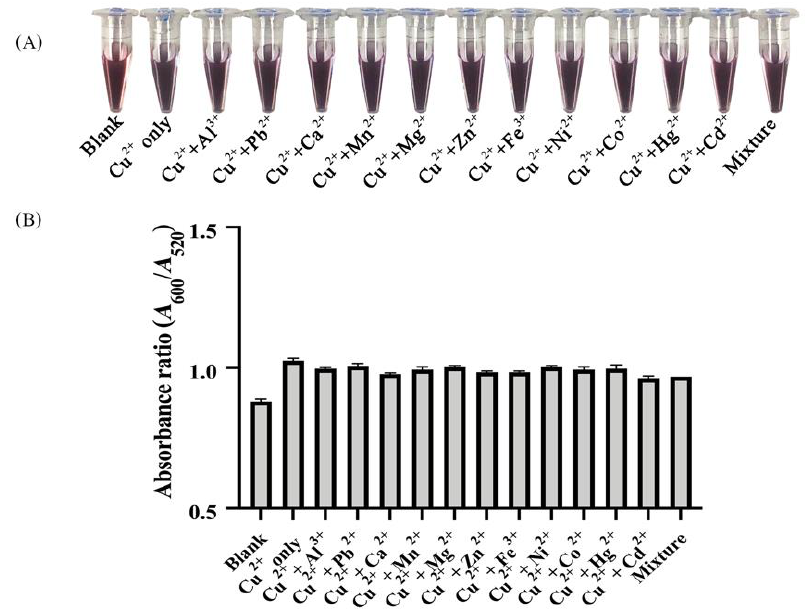
Figure 8. ( A ) Color changes and ( B ) the absorption peak ratios at 600 nm and 520 nm, i.e., A 600 / A 520 , of solutions containing 1 ppm Cu 2+ ion and 1 ppm of the indicated interference metal ions, as well as a solution mixing 1 ppm of these eleven interference metal ions